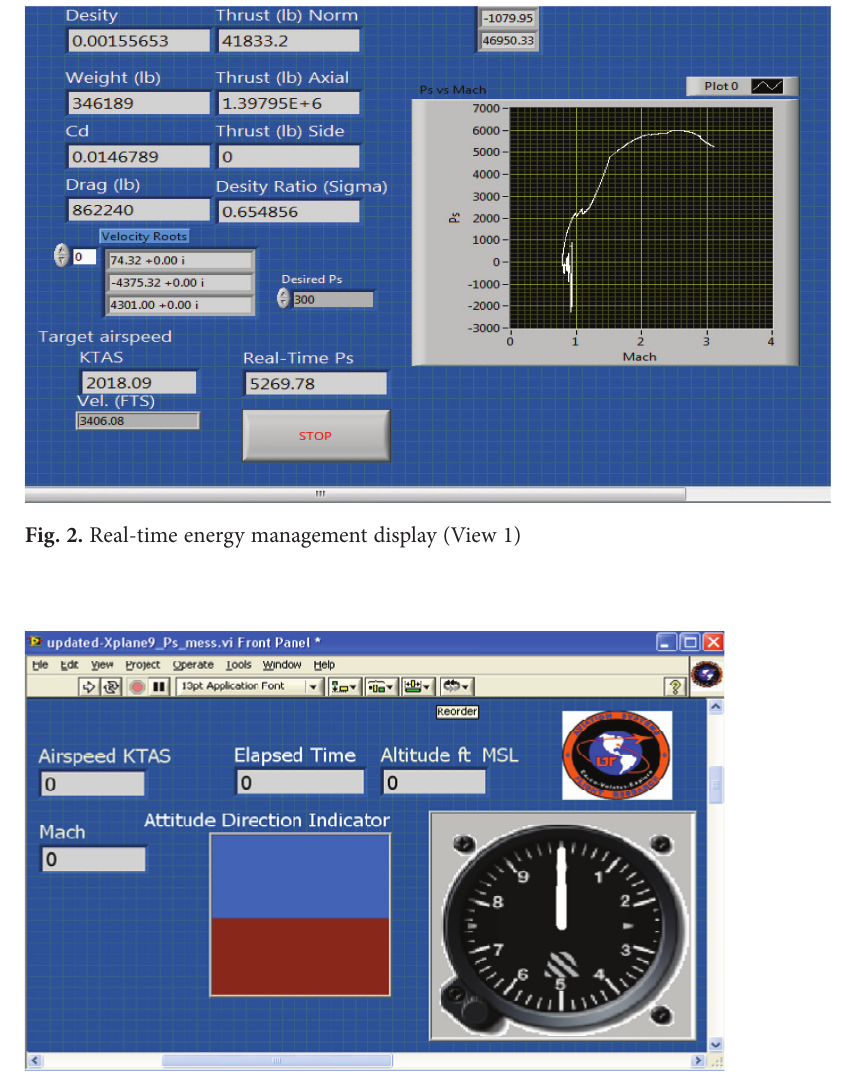
Fig. 3. Real-time energy management display (View 2)